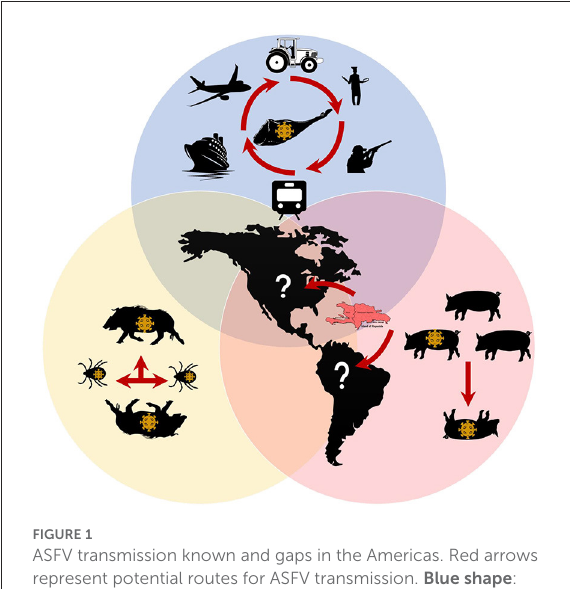
FIGURE1 ASFV transmission known and gaps in the Americas. Red arrows represent potential routes for ASFV transmission. Blue shape : Human movement with contaminated fomites or contaminated pork represent the major risk for naive populations. Yellow shape : The potential role of wild Boars and Ornithodoros tick vectors still to be determined in the Americas. Orange shape : Virus transmission in pig farms has been confirmed in the Dominican Republic and Haiti. See text for